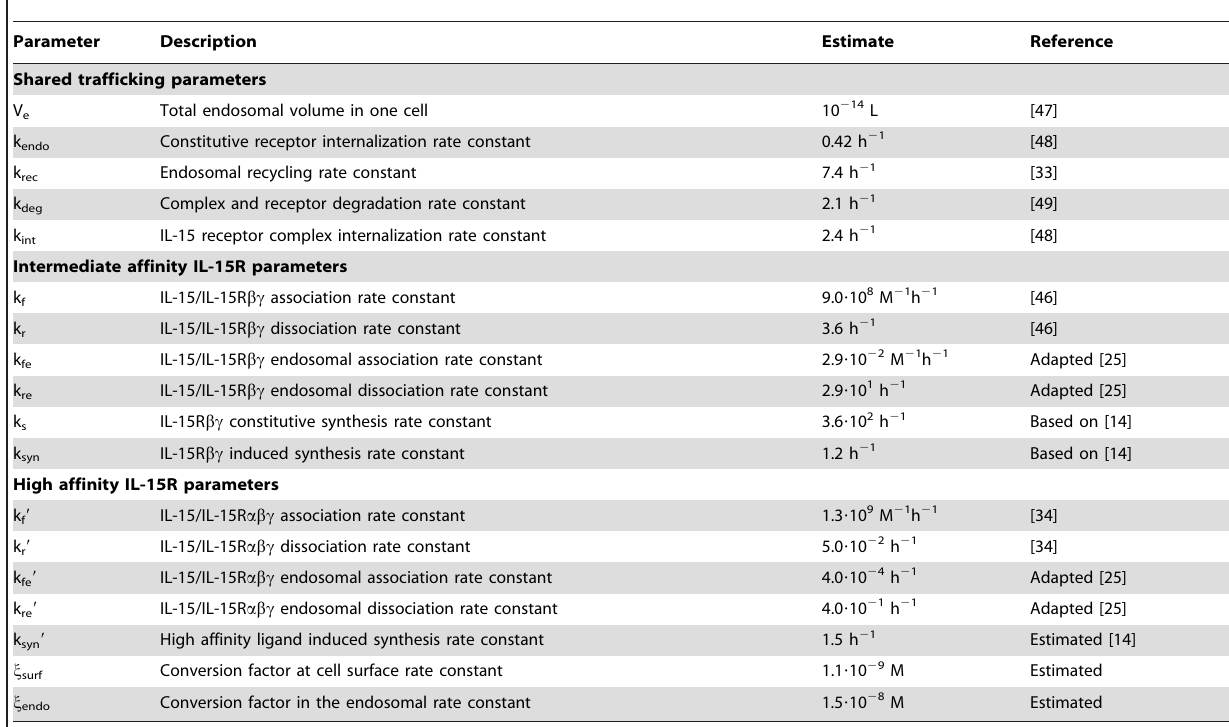
Shared trafficking parameters and unique binding and synthesis parameters for the intermediate and high affinity IL-15R were obtained or estimated from published experimental measurements. N A represents Avogadro’s number.